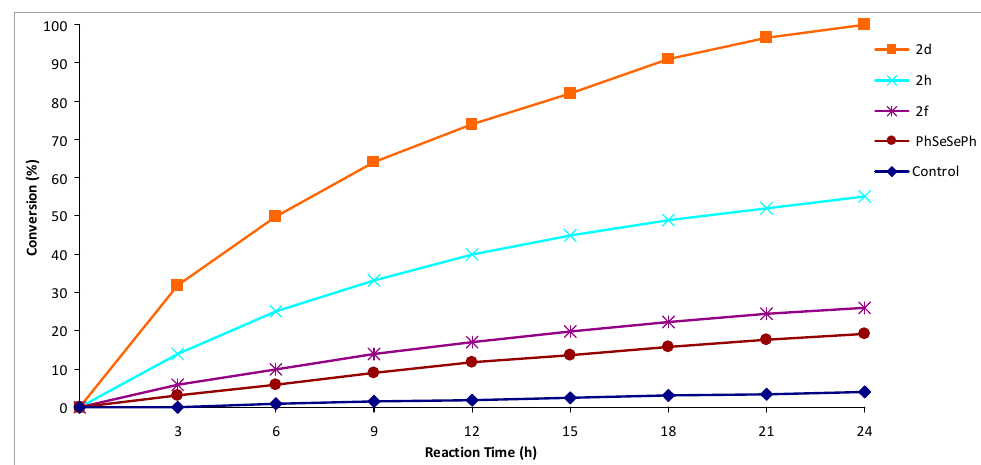
Figure 3. Studying glutathione peroxidase-like activity of compounds 2d , f , h by 1 H NMR monitoring with the use of Ph 2 Se 2 as the standard compound (TBHP, BnSH, 0.1 mmol, deuterochloroform, 0.5% mol of studied compounds). The control experiment was carried out in the absence of studied compounds.